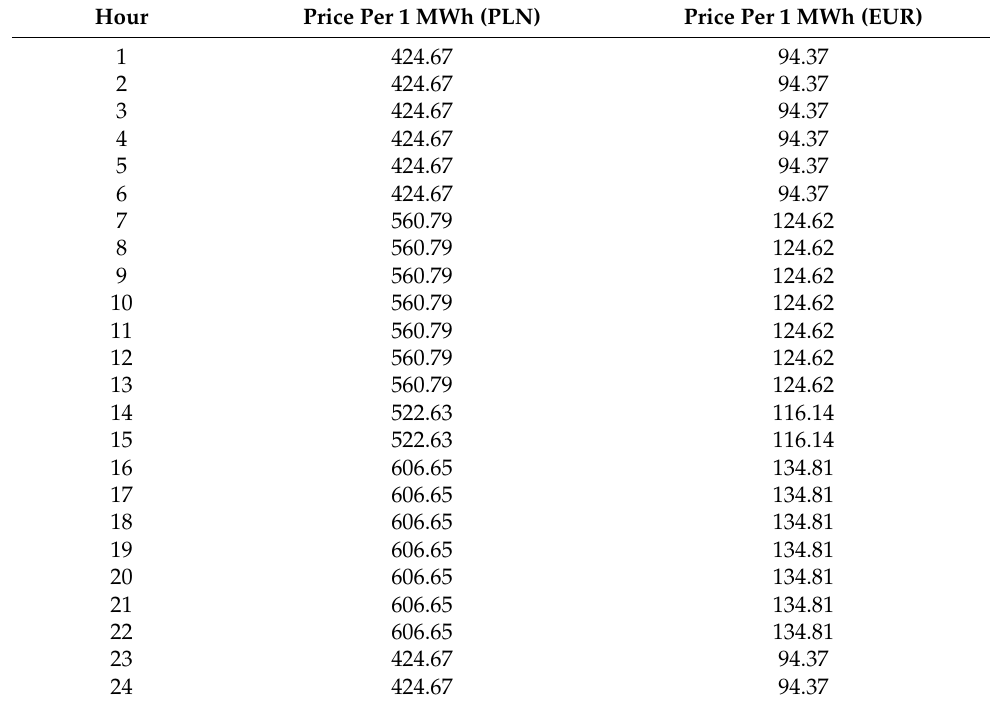
Table 1. Energy cost in one-day period based on energy invoice for the investigated company— consumer tariff